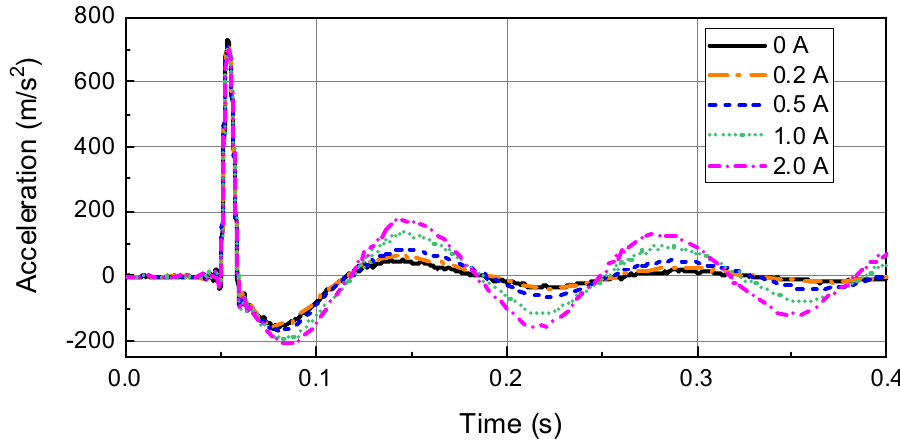
Figure 13. Simulation result of the waveform prediction program.